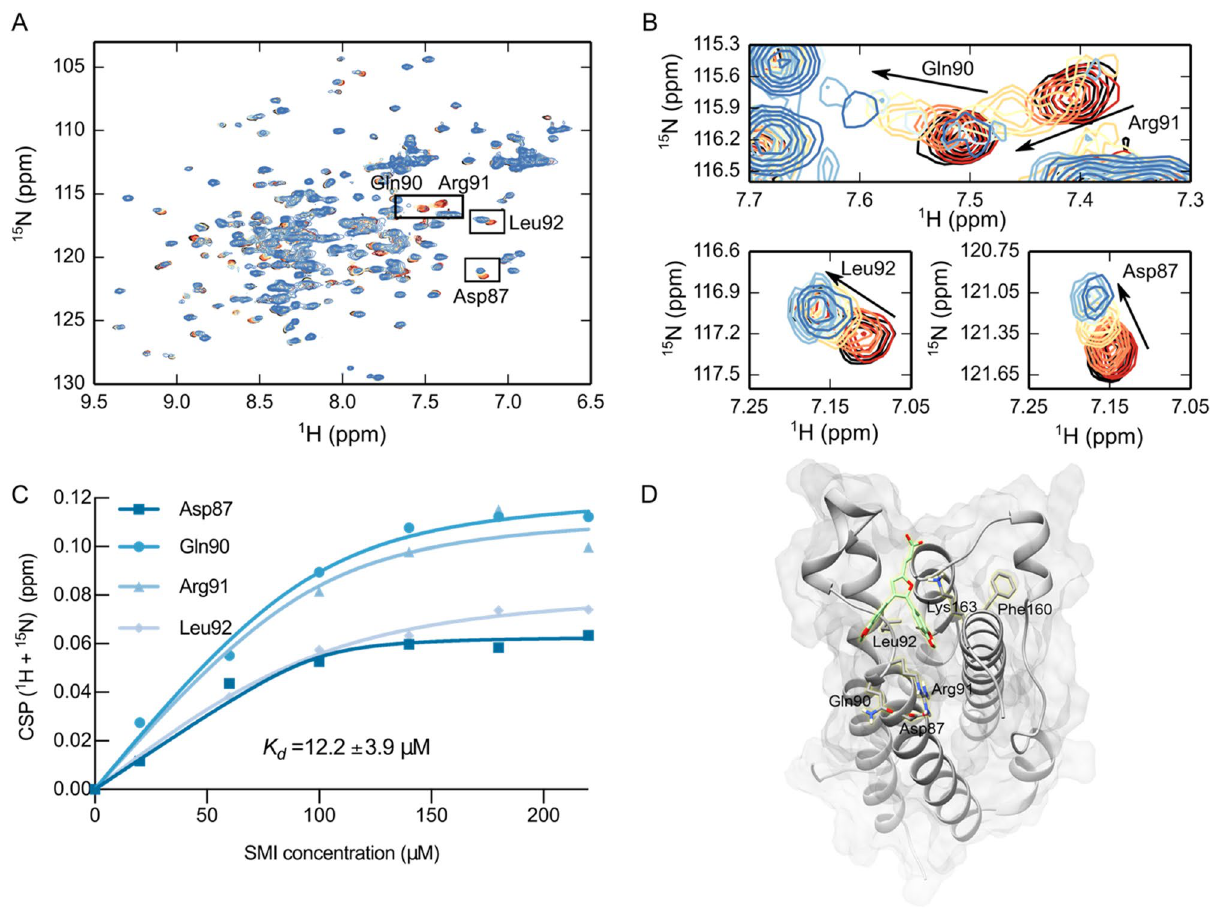
Figure 8. SMI titration of 15 N rhOSM monitored by NMR spectroscopy. ( A ) An overlay of 1 H, 15 N HSQC NMR spectra of 100 μM 15 N-labeled OSM with cross peaks color-ramped from red to blue with increasing SMI concentration from 20 μM (red) to a final concentration of 220 μM (blue). A DMSO control is shown in black. ( B ) Zoomed regions of panel A for Asp87, Gln90, Arg91, and Leu92. ( C ) A saturation binding curve was fit to the CSP vs. SMI for peaks that were tentatively assigned to Asp87, Gln90, Arg91, and Leu92. ( D ) OSM oriented with Site III in view with protruding Phe160 and Lys163 residues (shown as sticks and colored gold),